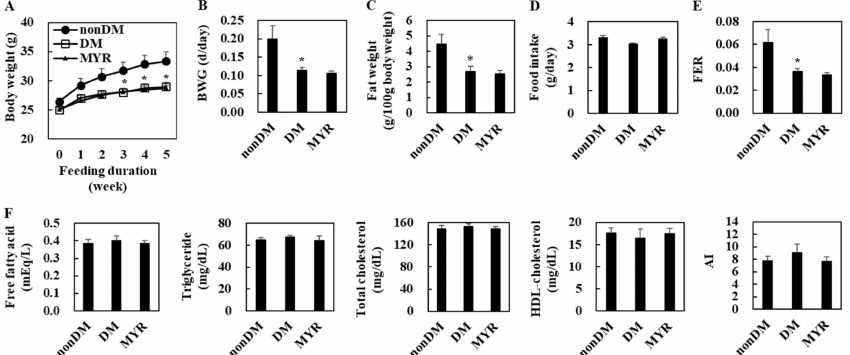
Figure 1. E ff ects of myricitrin (MYR) on change in body weight ( A ), body weight gain ( B ), fat weight ( C ), food intake ( D ), food e ffi ciency ratio (FER) ( E ), and plasma lipids levels ( F ) in high-fat diet (HFD) / streptozotocin (STZ)-induced diabetic mice. Values are means ± SE ( n = 10). Student’s t -test